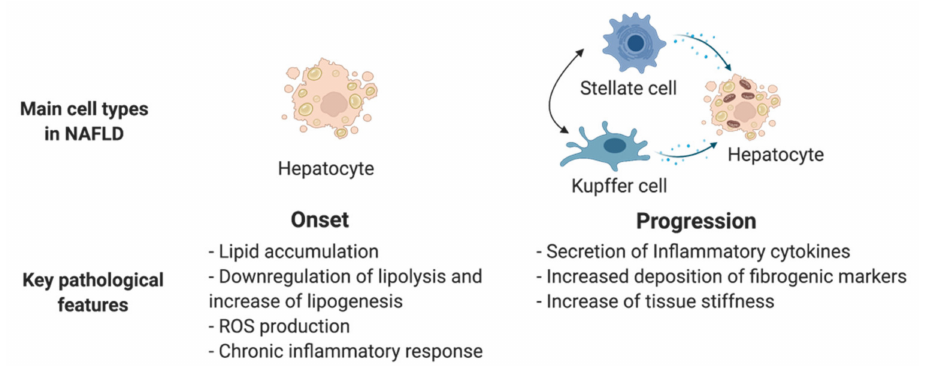
Figure 4. Main cell types and key pathological features in existing NAFLD models. ROS: reactive oxygen species. This figure was created with